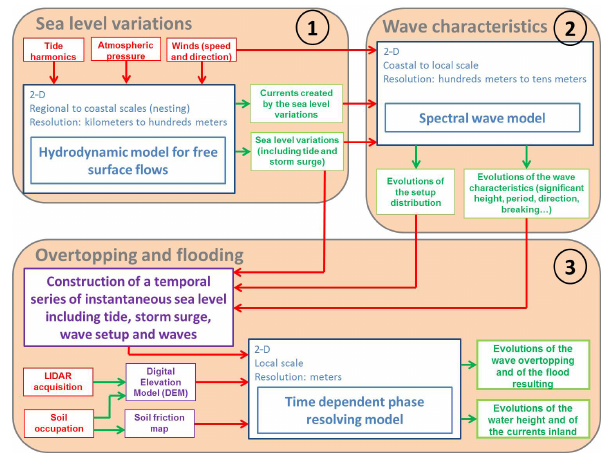
Figure 1. Modelling method proposed to simulate wave overtop- ping and associated